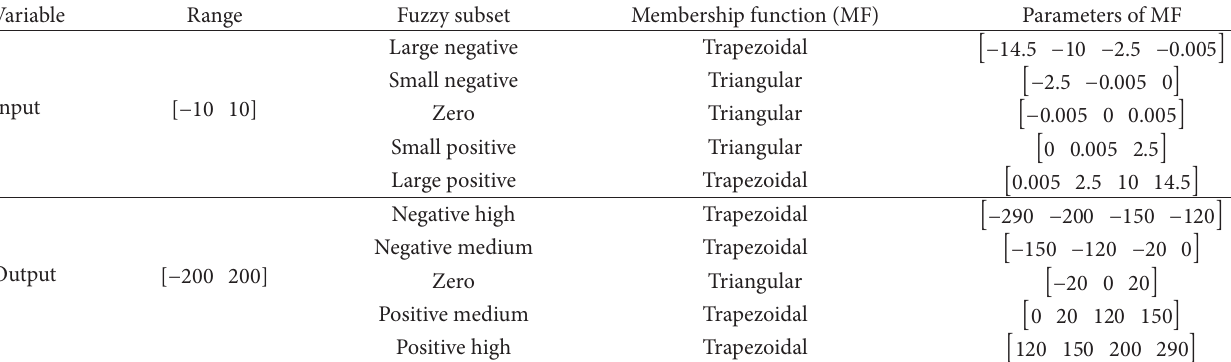
Table 1: Design parameters of the MFLC.